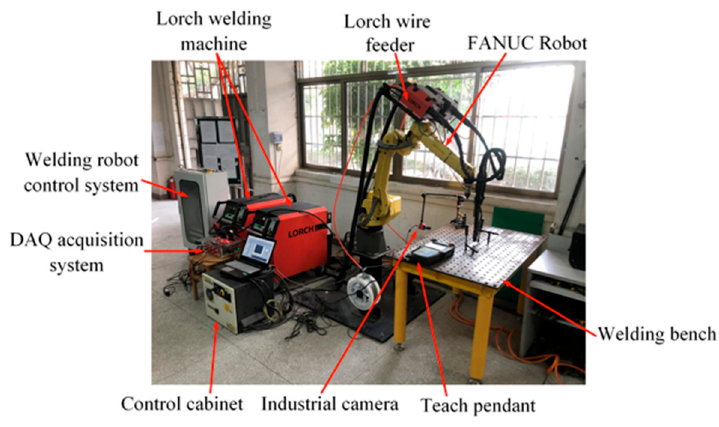
Figure 1. Robot arc additive manufacturing platform. Table 1. Chemical composition of the welding wire and substrate (mass fraction, %).